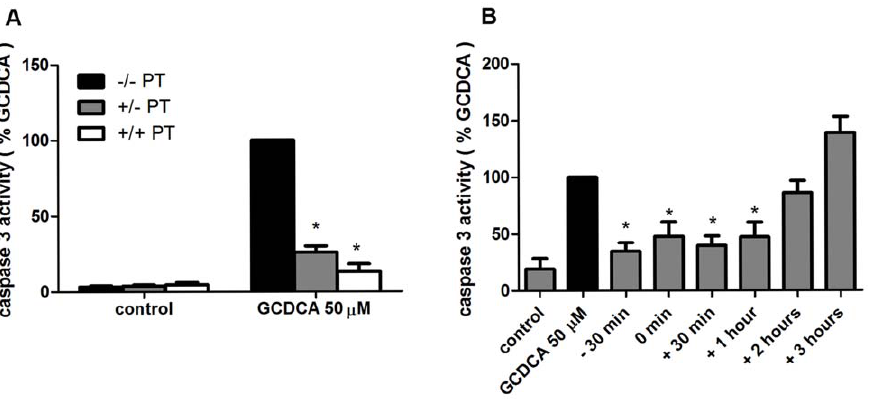
Figure 2. The protective effect of pertussis toxin (PT) against glycochenodeoxycholic acid (GCDCA)-induced apoptosis. ( a ) Hepatocytes were pre-incubated with 200 nmol/L of PT for 15 hours after which cells were washed and exposed to 50 m mol/L of GCDCA alone ( + / 2 PT) or with simultaneous addition of PT ( + / + PT). * P , 0.05 for GCDCA + PT ( + / 2 ) and GCDCA + PT ( + / + ) vs. GCDCA 50 m M. ( b ) hepatocytes were stimulated with 50 m mol/L GCDCA for 4 hours (GCDCA 50 m M). PT (200 nmol/L) was added 30 minutes prior to ( 2 30 min), simultaneous with (0